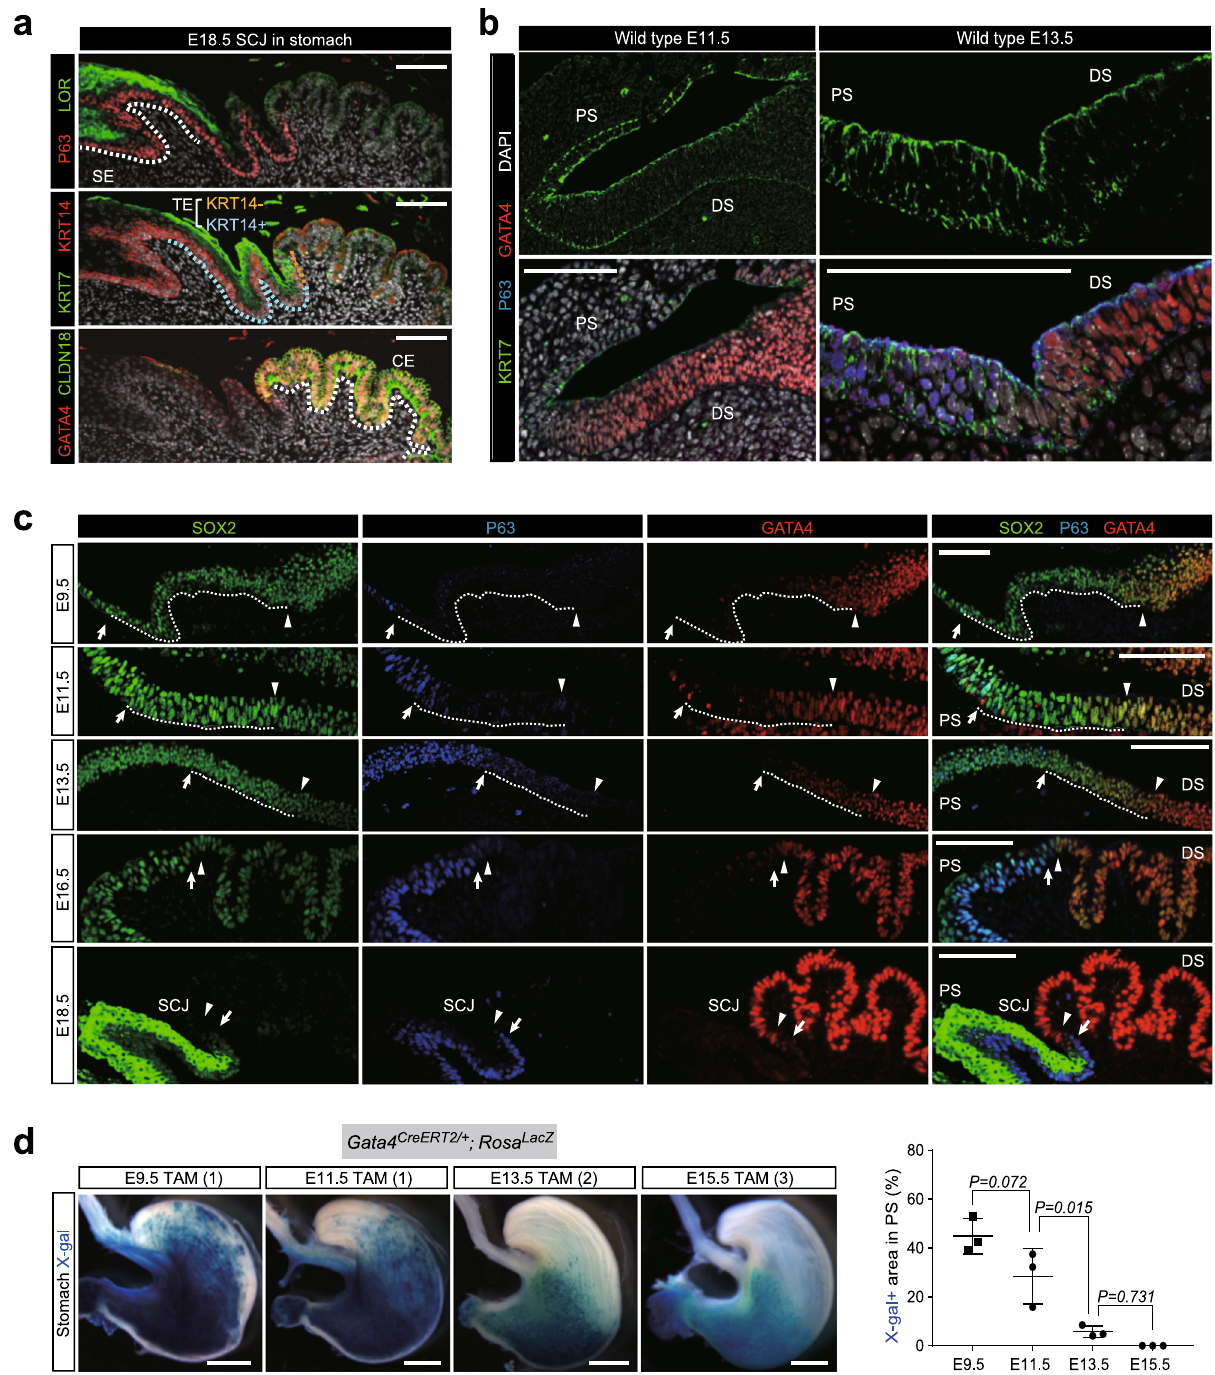
Fig. 1 Expression patterning of SOX2 and GATA4 in the stomach epithelium during SCJ development. a Immuno fl uorescence (IF) analyses of P63 and LOR (top), KRT7 and KRT14 (middle), or GATA4 and CLDN18 (bottom) for the SCJs of wild-type stomachs at E18.5. All samples were counterstained with DAPI. SE squamous epithelium, TE transitional epithelium, CE columnar epithelium. Presented data are a representative image of n = 5. Scale bar, 100 µ m. b IF analyses of KRT7, P63, and GATA4 for wild-type stomachs at E11.5 and E13.5. PS proximal stomach epithelium, DS distal stomach epithelium. Presented data are a representative image of n = 5. Scale bar, 100 µ m. c IF analyses of SOX2, P63, and GATA4 for wild-type stomachs at E9.5, E11.5, E13.5, E16.5, and E18.5. Arrows indicate the P63 + cells on the epithelium at the most caudal side. Arrowheads indicate GATA4 + epithelial cells at the most rostral side. Dashed lines indicate the intermediate epithelial cells with low expression of both P63 and GATA4. Presented data are a representative image of n = 4. Scale bar, 100 µ m. d Left: whole-mount X-gal staining on the stomach of the Gata4 CreERT2/ + ; Rosa lacZ embryos. Presented data are a representative image of n > 8 embryos out of three independent experiments. Scale bars, 1 mm. Right: quanti fi cation of the X-gal + area in the proximal stomach. Data are presented as mean values ± SD. n = 3 independent experiments, one-way